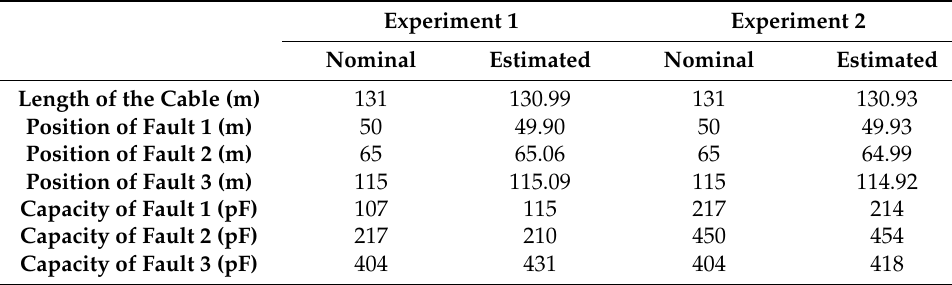
Table 6. Estimation results for real cables with three capacitive faults.